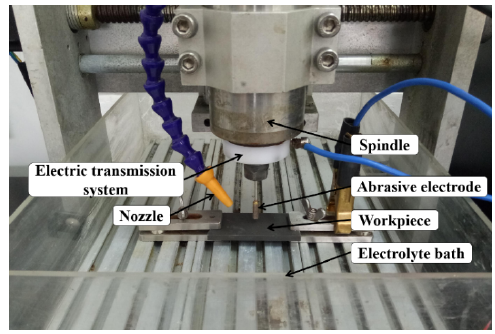
Figure 4: The actual experimental setup.